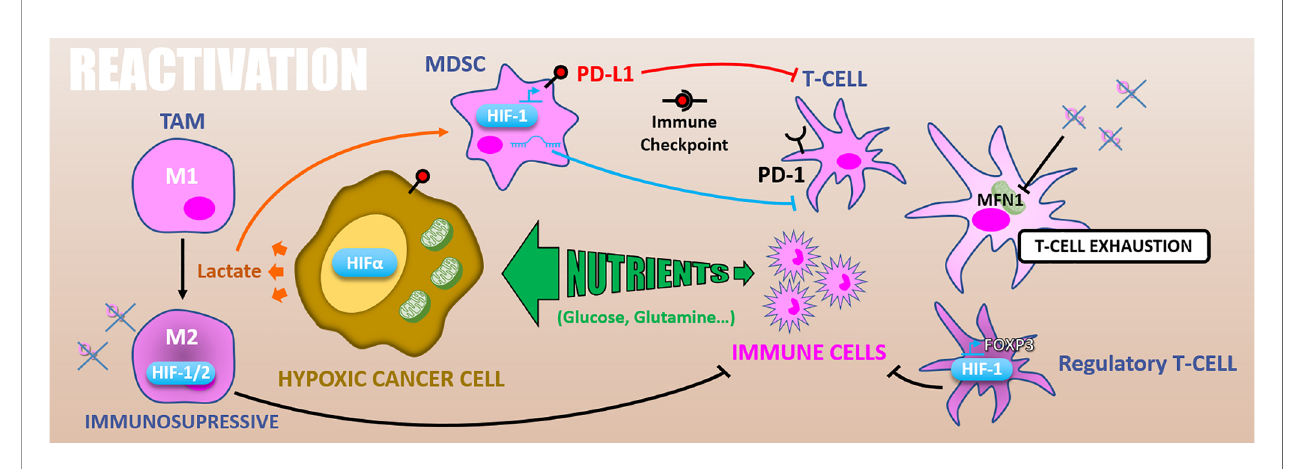
FIGURE 8 | Reactivation. Because of exacerbated metabolism, hypoxic cancer cells consume nutrients from the microenvironment and starve immune cells. In addition, glycolytic metabolism produces lactate which polarizes TAMs in M2 immuno-suppressive and activates MDSCs inhibiting T-cells. HIFs expression in TAMs increases their immunosuppressive activity. Also, in MDSCs HIF-1 promotes PD-L1 expression that inhibits T-cell through PD-1/PD-L1 immune checkpoint. HIF-1 a differentiates T-cells into immunosuppressive regulatory T-cells via FOXP3 expression. Finally, hypoxia can cause T-cells exhaustion by reducing their energetic metabolism through MFN1